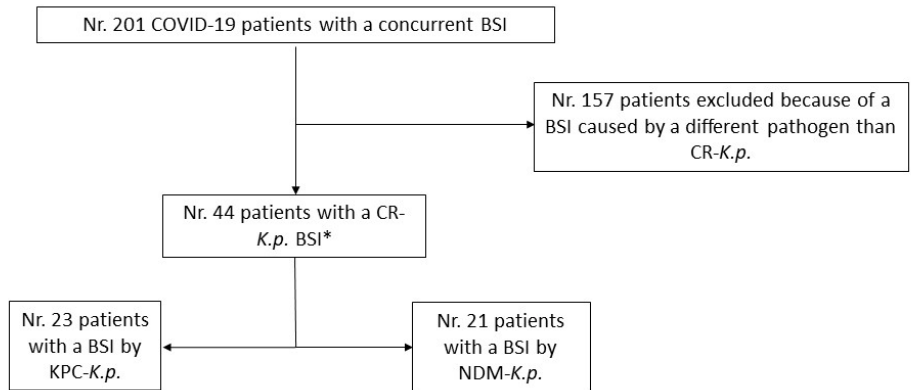
Figure 1. Patient flow-chart. Legend: BSI = Bloodstream infection; CR- K.p. = Carbapenem-resistant